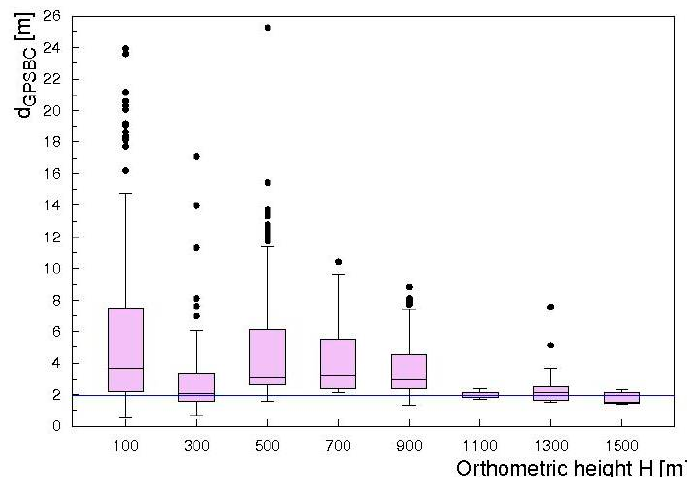
Figure 7. Boxplot of the distribution of d GPSBC as a function of the orthometric height H for entire 0.2 Hz dataset. The blue line represents the (1.96 ± 0.01) m reference distance between GPSB and GPSC. Black points represent outlier data.